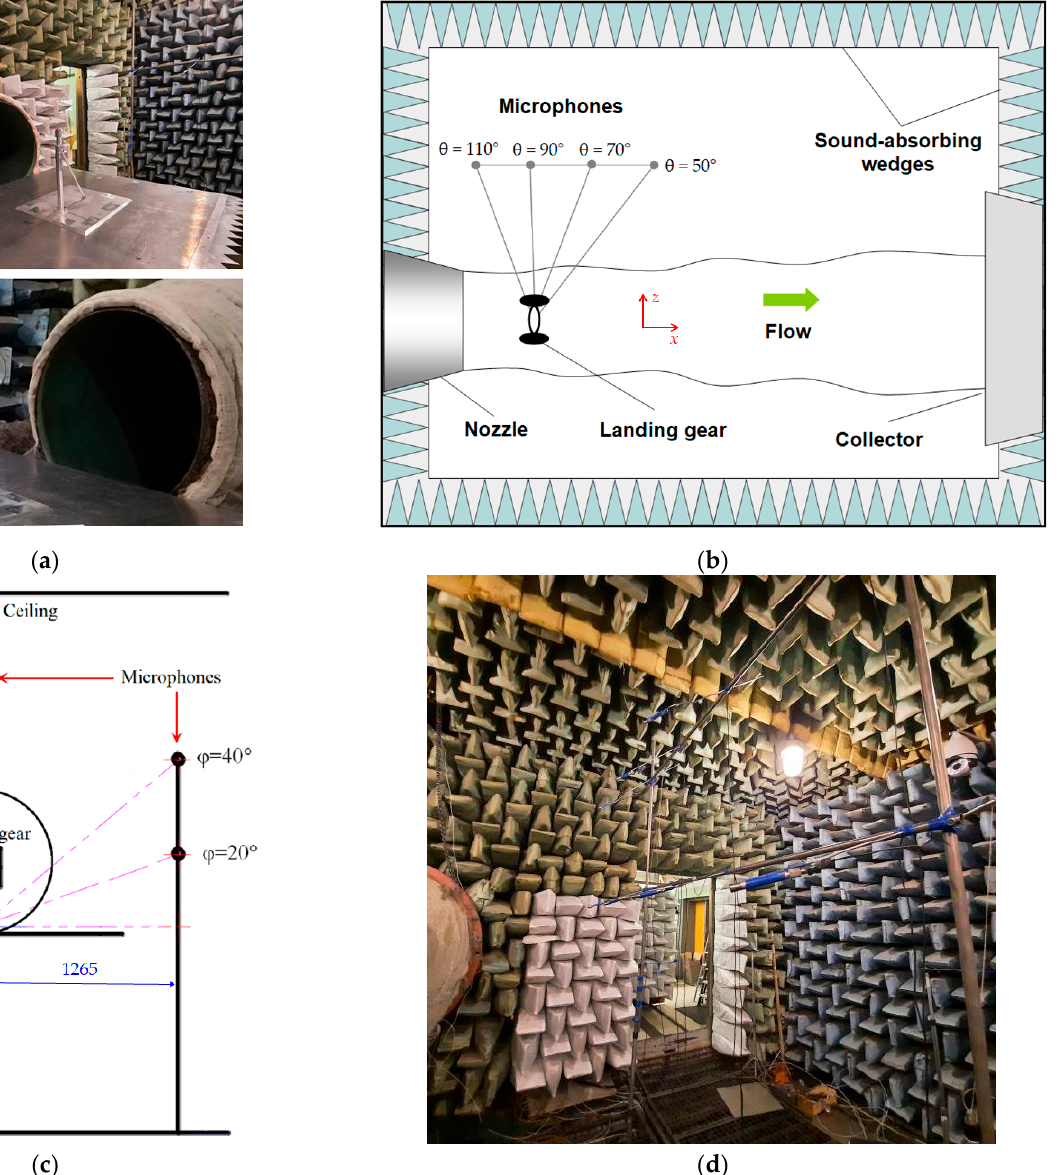
Figure 2. Landing gear noise tests in AC-2 TsAGI: ( a ) photo of a small-scale model installed on the horizontal plate; ( b ) scheme of the experiment (top view); ( c ) scheme of the experiment (front view); ( d ) photo of microphones installed in AC-2 TsAGI.